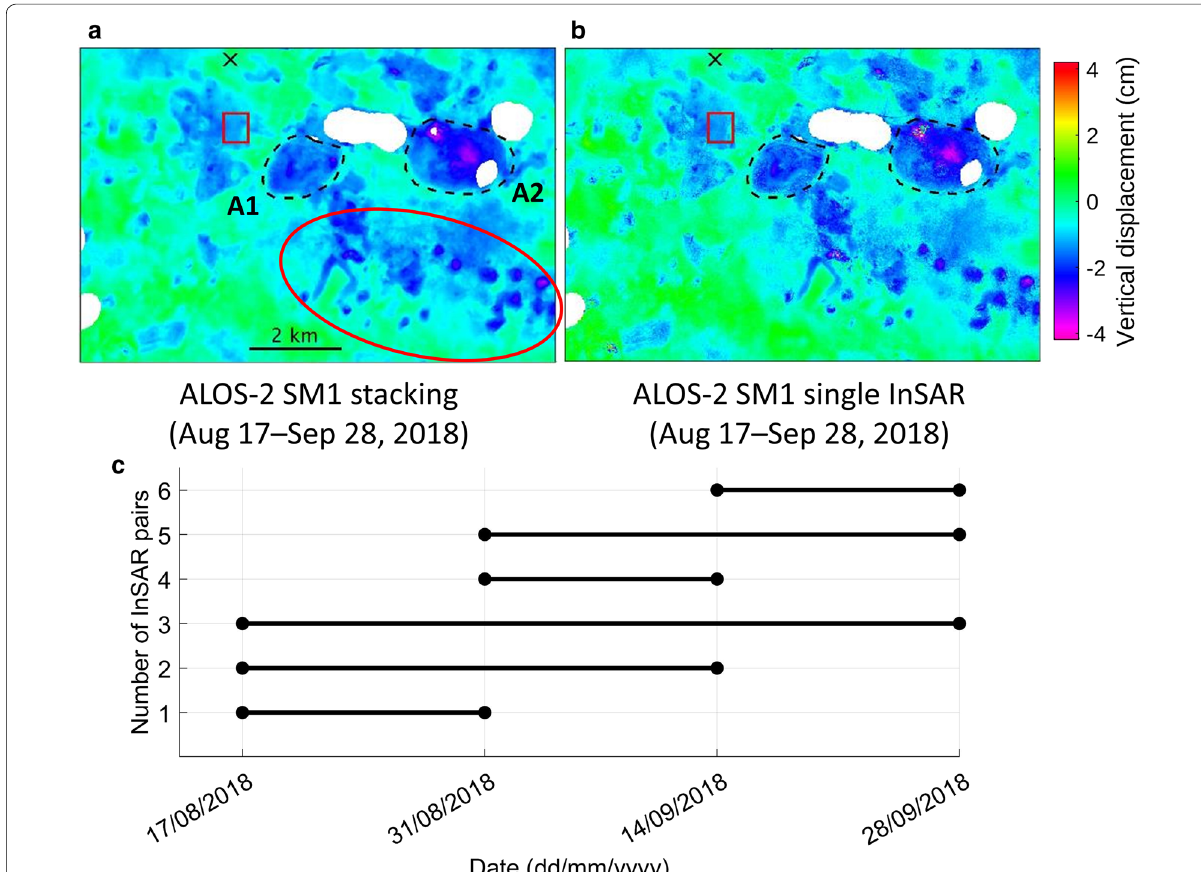
Fig. 5 a Stacked vertical displacement between August 17 and September 28, 2018, derived from ALOS-2 SM1 data. The red circle shows smaller spatial-scale subsidence than that in Fig. 4. b Vertical displacement between August 17 and September 28, 2018 derived from a single InSAR (as in Fig. 3c). c Temporal distribution of InSAR pairs for